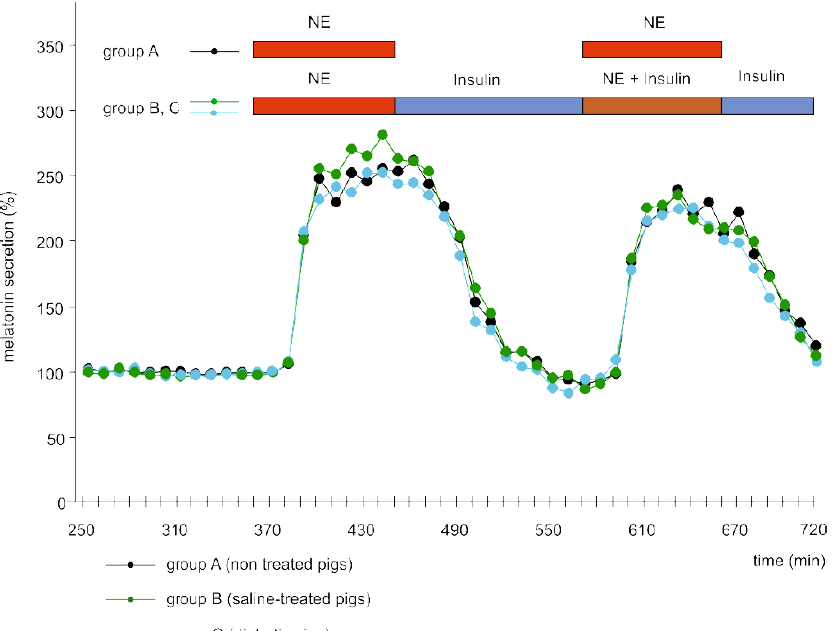
Figure 3. Melatonin secretion from explants of the pineal glands of normal, non-treated pigs (group A), control, saline-treated pigs (from the in vivo experiment, group B) and diabetic, streptozotocin-treated pigs (from the in vivo experiment, group C). The explants from groups A, B, and C were incubated in medium containing 10 µ M NE between 361 and 450 min of the experiment. Next, the explants of group B and C were incubated in a medium containing 10 µ M of insulin to the end of culture and stimulated with NE (10 µ M) between 571 and 660 min of the experiment. The explants of group A were incubated in medium without insulin and treated with NE between 571 and 660 min of the experiment. The mean melatonin secretion between 300 and 360 min of the experiment was taken as 100%. The data presented are means ( n = 5). Horizontal bars show respective periods of incubation in medium with NE, insulin, or NE + insulin.